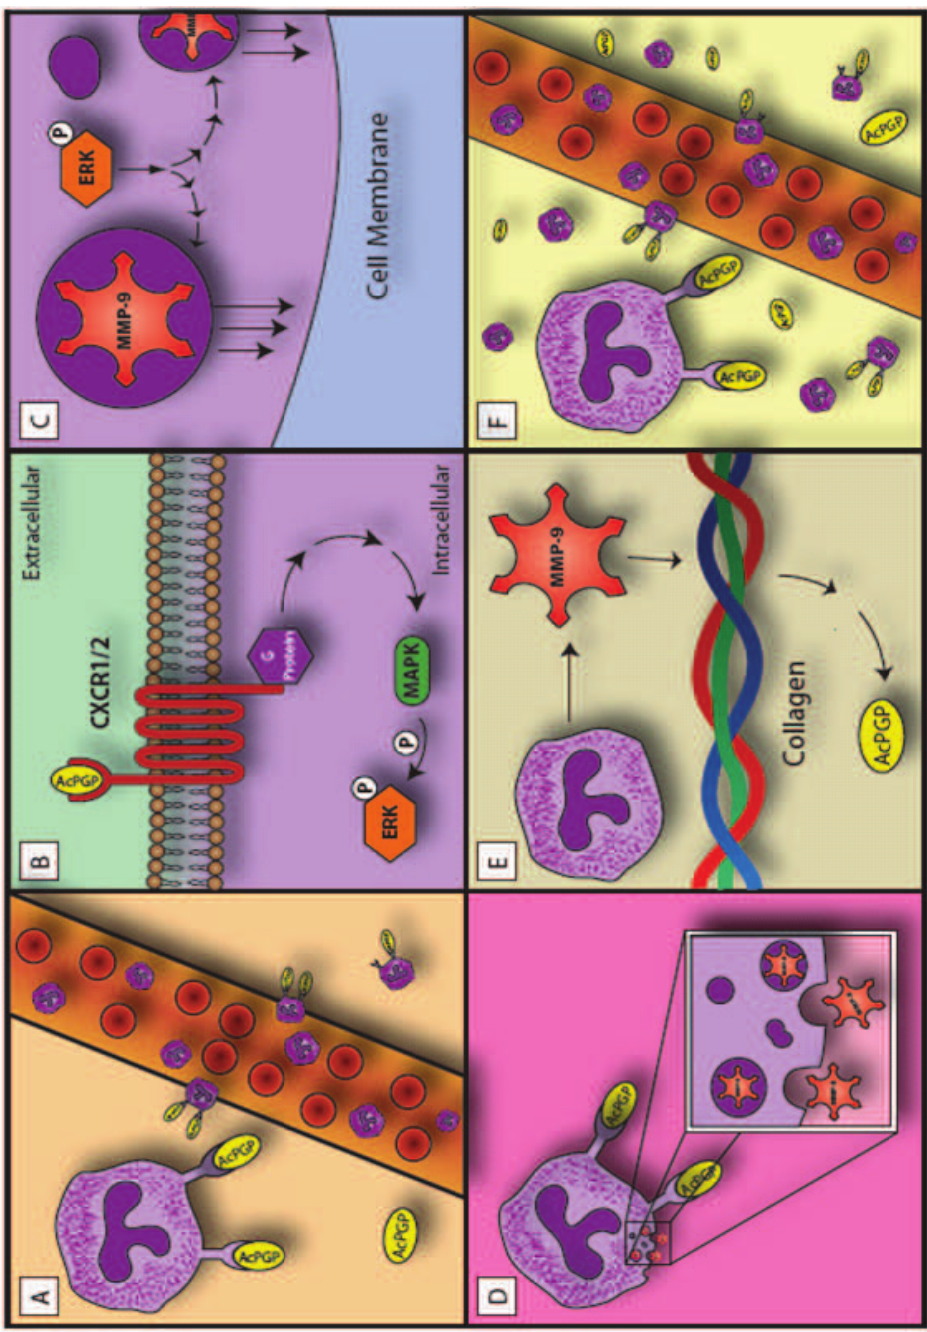
Figure 6. A model of persistent matrikine production and neutrophilic inflammation. During chronic PMN inflammation, collagen is hydrolyzed releasing Ac-PGP causing ongoing neutrophilic influx ( A ). In addition to causing PMN influx, Ac-PGP ligation of CXCR1 and CXCR2 leads to intracellular ERK phosphorylation and activation ( B ) and degranulation of MMP-9 from PMN tertiary granules ( C and D ). This MMP-9 acts on exposed collagen leading to Ac-PGP generation ( E ) and a feed-forward inflammatory response on PMNs ( F ). doi:10.1371/journal.pone.0015781.g006 concentration of samples was determined by interpolation from the standard curve.